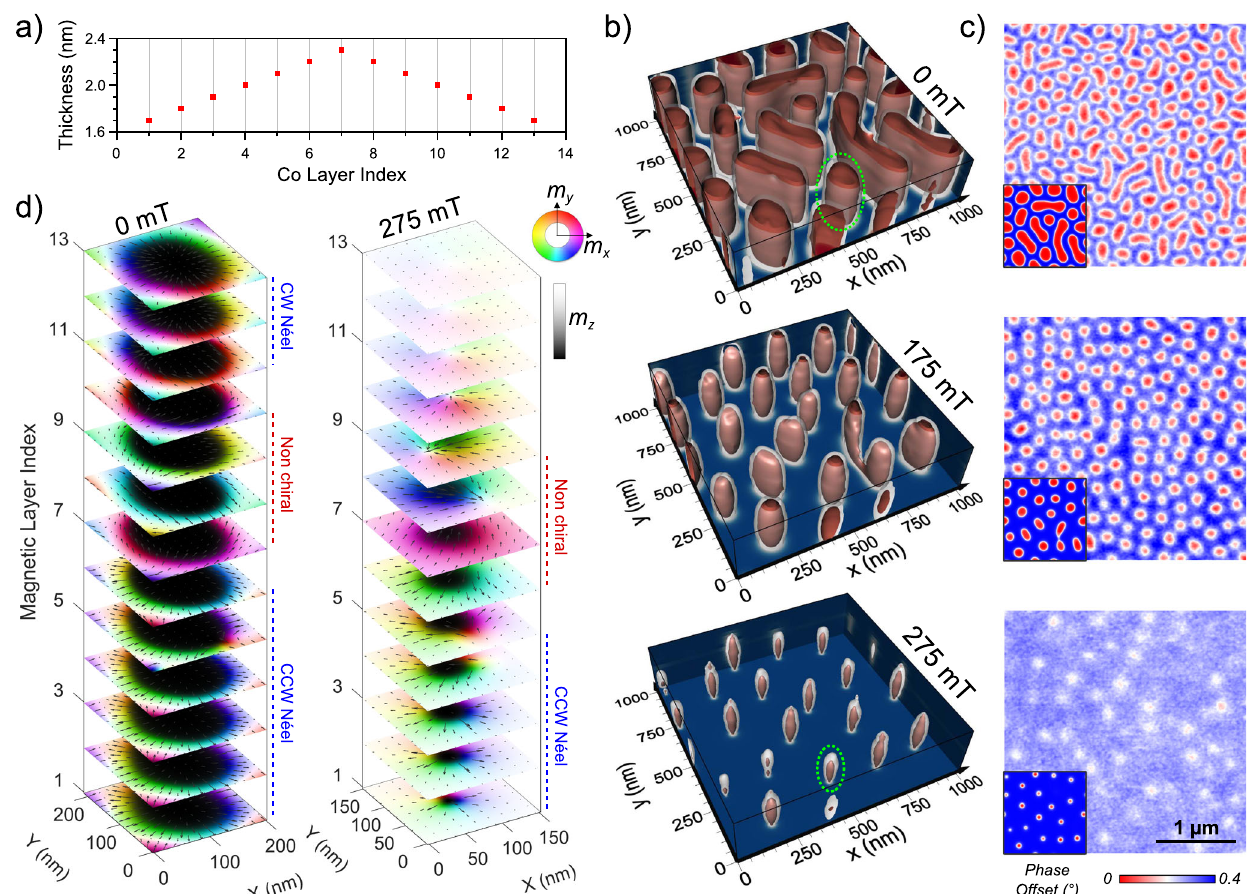
Fig. 1 | Properties of Single Gradient (SG) multilayers with parameters images obtained with MFM accompanied by simulated ones (1×1 μ m 2 ) at the S =0.1nm, X N =13 layers. a Evolution of the Co thickness for a typical bottom left corner.The experimentalmagnetic fi elds correspond to the simulated 1 =1.7nm, ones±10mT and point out-of-plane. The scales shown in the bottom image are SG multilayer, de fi ned by the number of layers N , the thickness step S , and the common to all MFM maps. d ) Magnetization cuts of a selected object, indicated in starting thickness X 1 . b Field evolution of the magnetic textures with micro- ( b ) by the green dotted ellipses, at two different magnetic fi elds to evidence the magneticsimulationsafteranout-of-planesaturationdisplayedwithisosurfaces(in vertical evolution and the chirality (CW: clockwise, CCW: red, m z = − 0.8,inwhite, m z =0andindarkblue, m z =1). c Correspondingphasemap